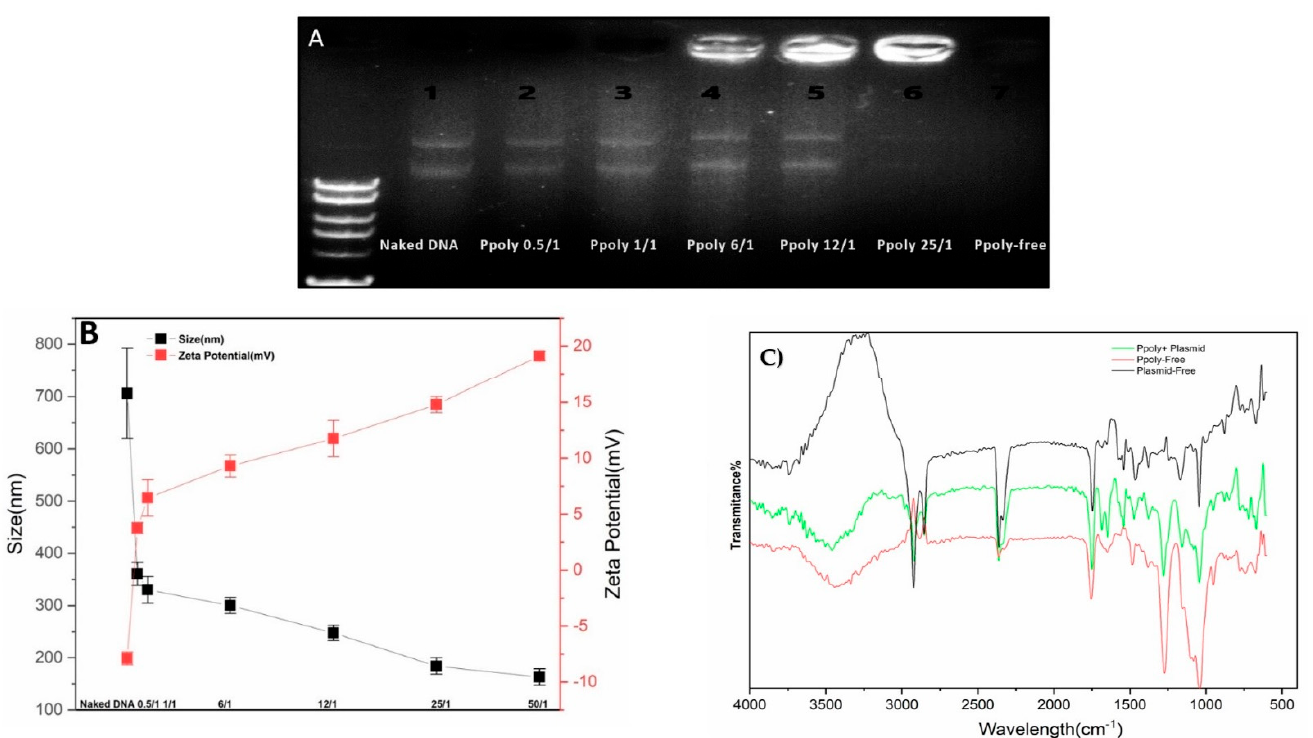
Figure 2. Characterization of PPoly–DNA nanocomplexes. ( A ) Agarose gel electrophoresis of PPoly–DNA nanocomplexes; ( B ) size of PPoly–DNA nanocomplexes at different N/P ratios and zeta potential of DLS; ( C ) the FTIR spectra of free PPoly, free DNA, and PPoly–DNA nanocomplexes. The results are expressed as means ± SD.